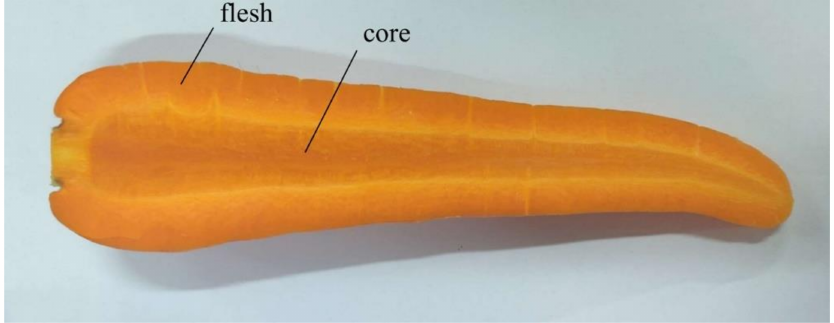
Figure 1. The longitudinal profile of carrot